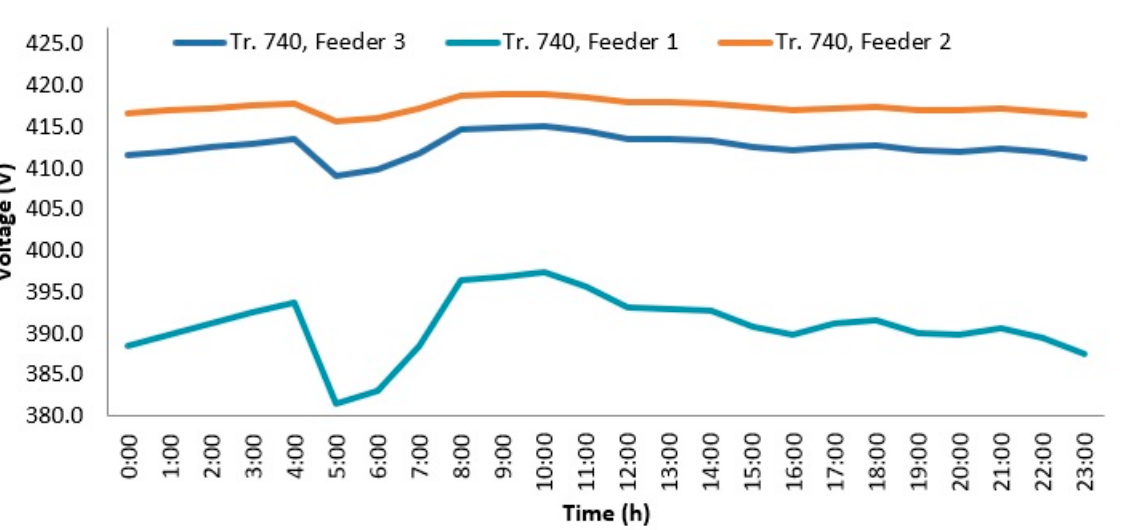
Figure 17. Voltage profiles at the end of Transformer 740 in summer with 60% EVC and overnight charging.